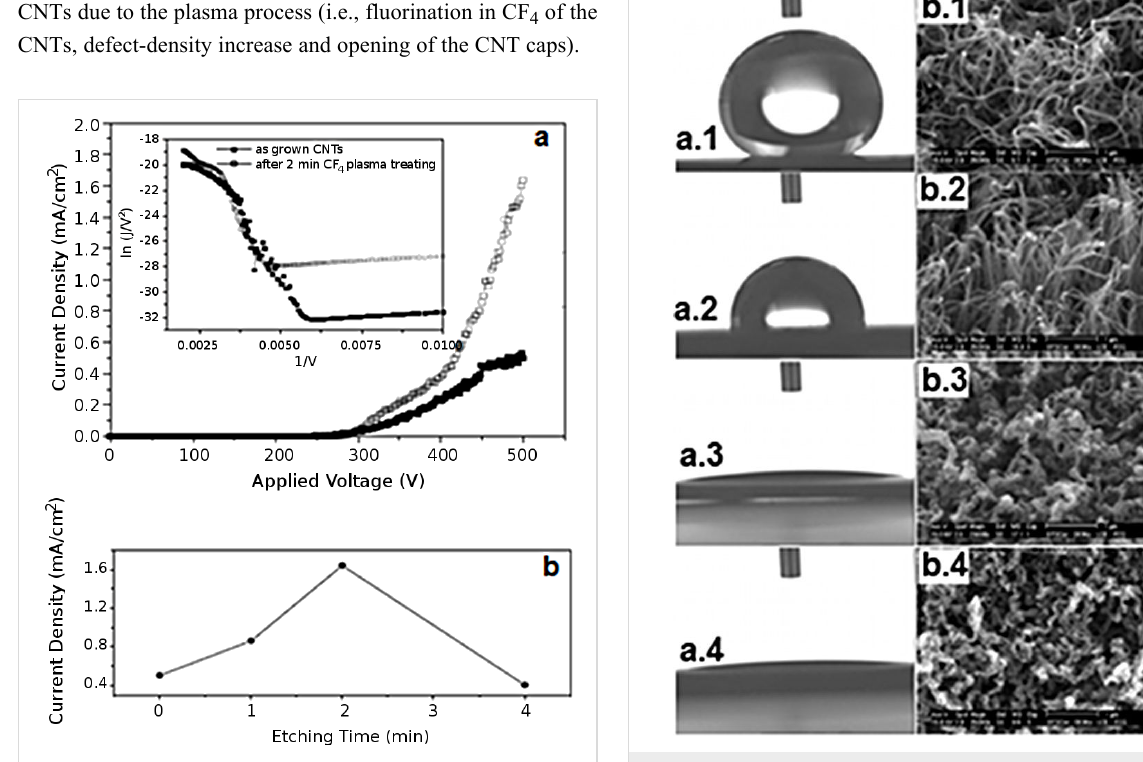
Figure 8: (a) Field-emission data of a CNT film before and after 2 min of CF 4 plasma treatment. Inset is the corresponding Fowler–Nordheim plots. (b) Dependence of the field-emission current density of aligned multiwall CNTs on the CF 4 treatment time under an applied voltage of 500 V. Adapted with permission from [88]. Copyright 2005 Elsevier.